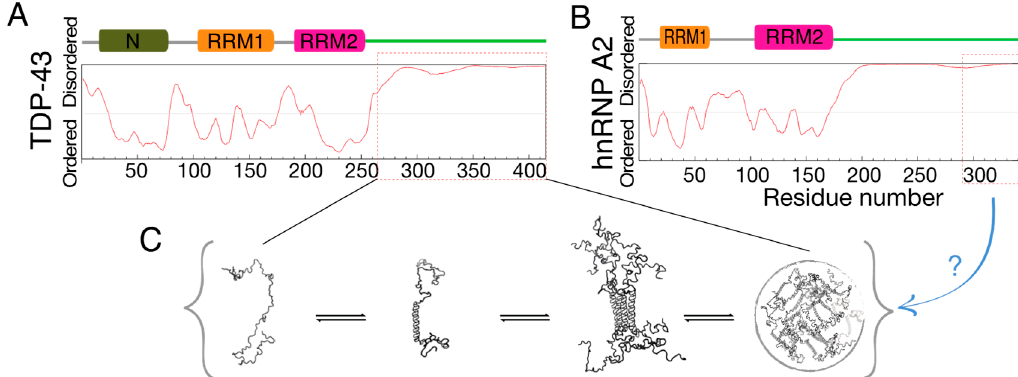
Figure 1. Schematic illustration of the intrinsically disordered regions (IDRs) of TDP-43 and hnRNP-A2 in this study. ( A , B ) The domains of ( A ) TDP-43 and ( B ) hnRNP-A2. The level of protein disorder was predicted using the PONDR VSL2 algorithm [36]. The fragments used in this study are indicated with red-dashed lines. ( C ) Schematic representation of the α -helical, self-association, and liquid-liquid phase separation propensities of TDP-43 reported in previous publications [37–39]. The molecular details of the effects of hnRNP-A2 remain elusive.